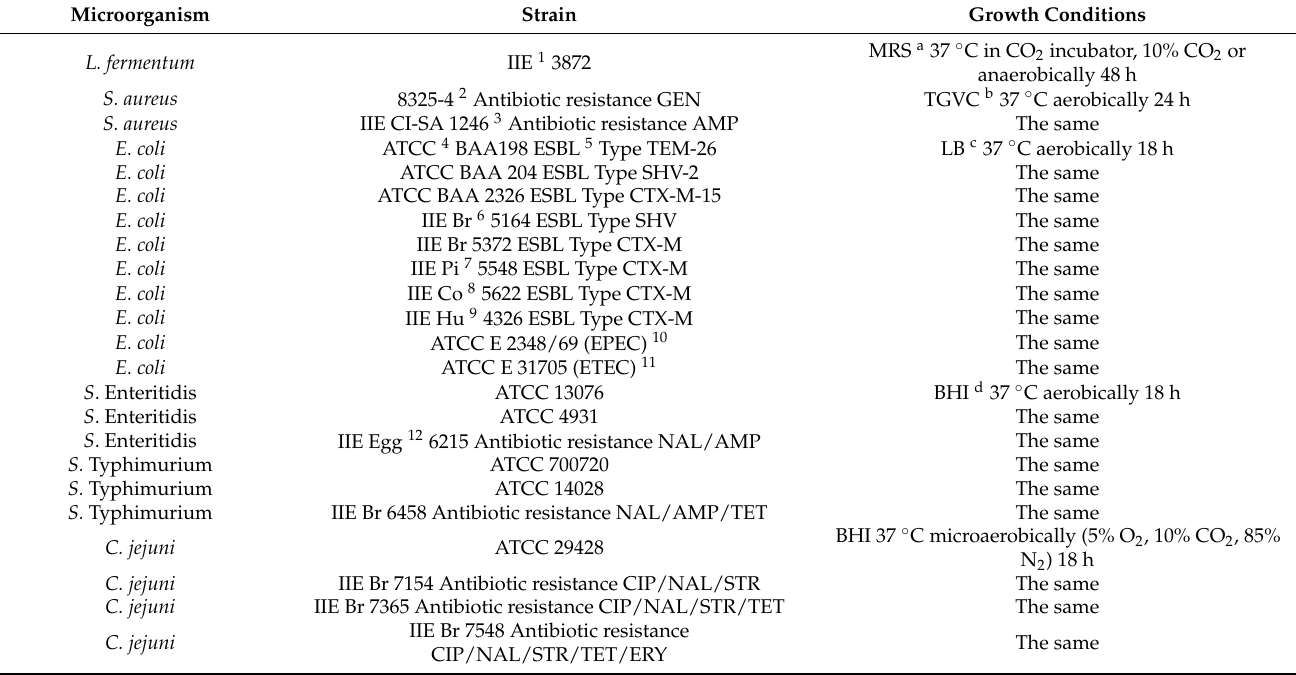
Table 9. Microorganisms used in this